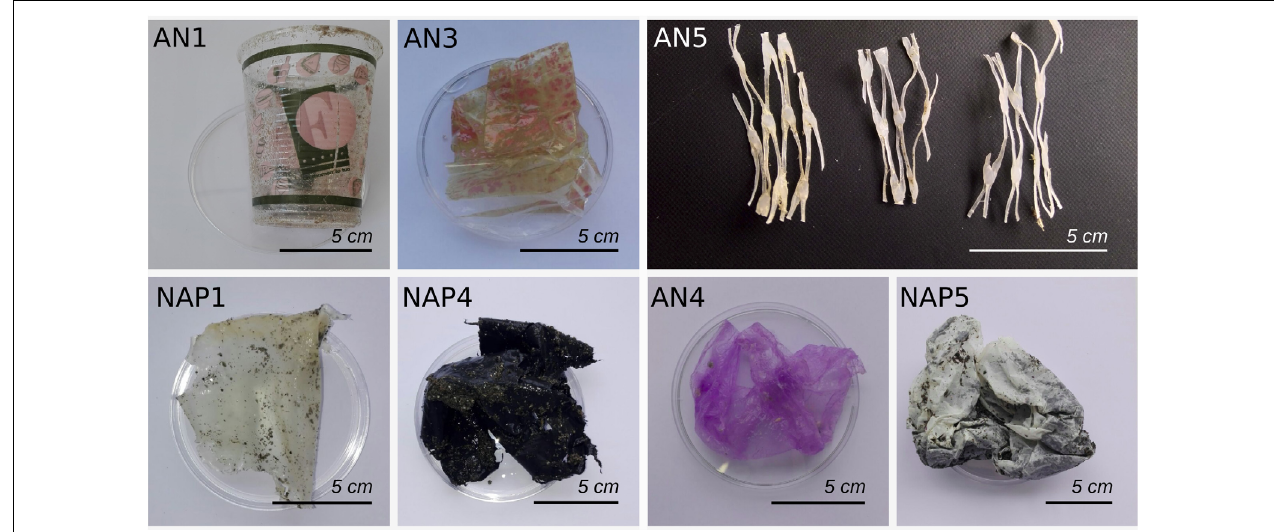
FIGURE 1 | Images of a selected subset of plastic items collected in this study from the Naples (NAP) and Ancona (AN) sites. As shown, different types of plastic items were collected, according to color, texture and size. Scale is